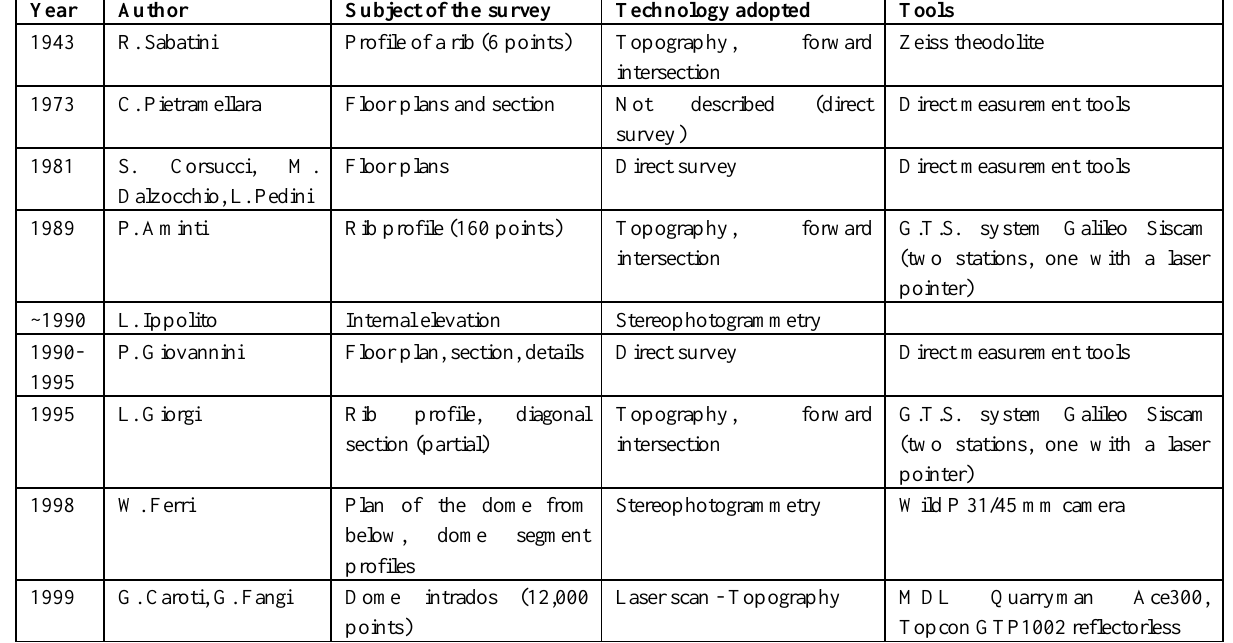
Table 1. A summary of previous metric studies on the